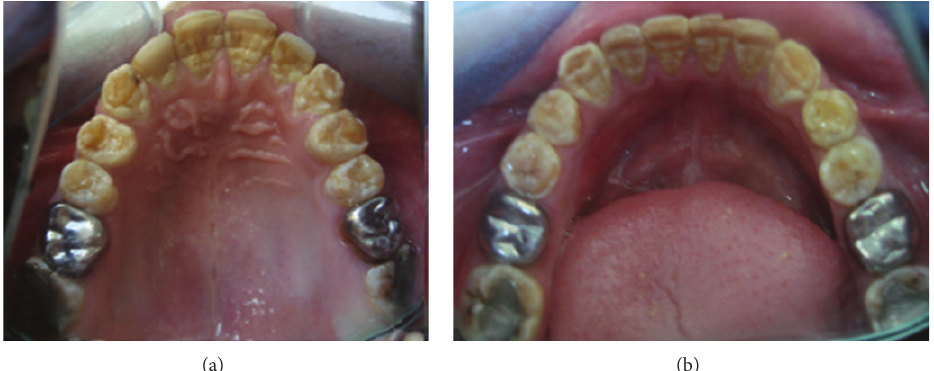
Figure 2: Typical intraoral appearance of dentinogenesis imperfecta. Stainless steel crowns had been applied during mixed dentition to preserve hard tissue.